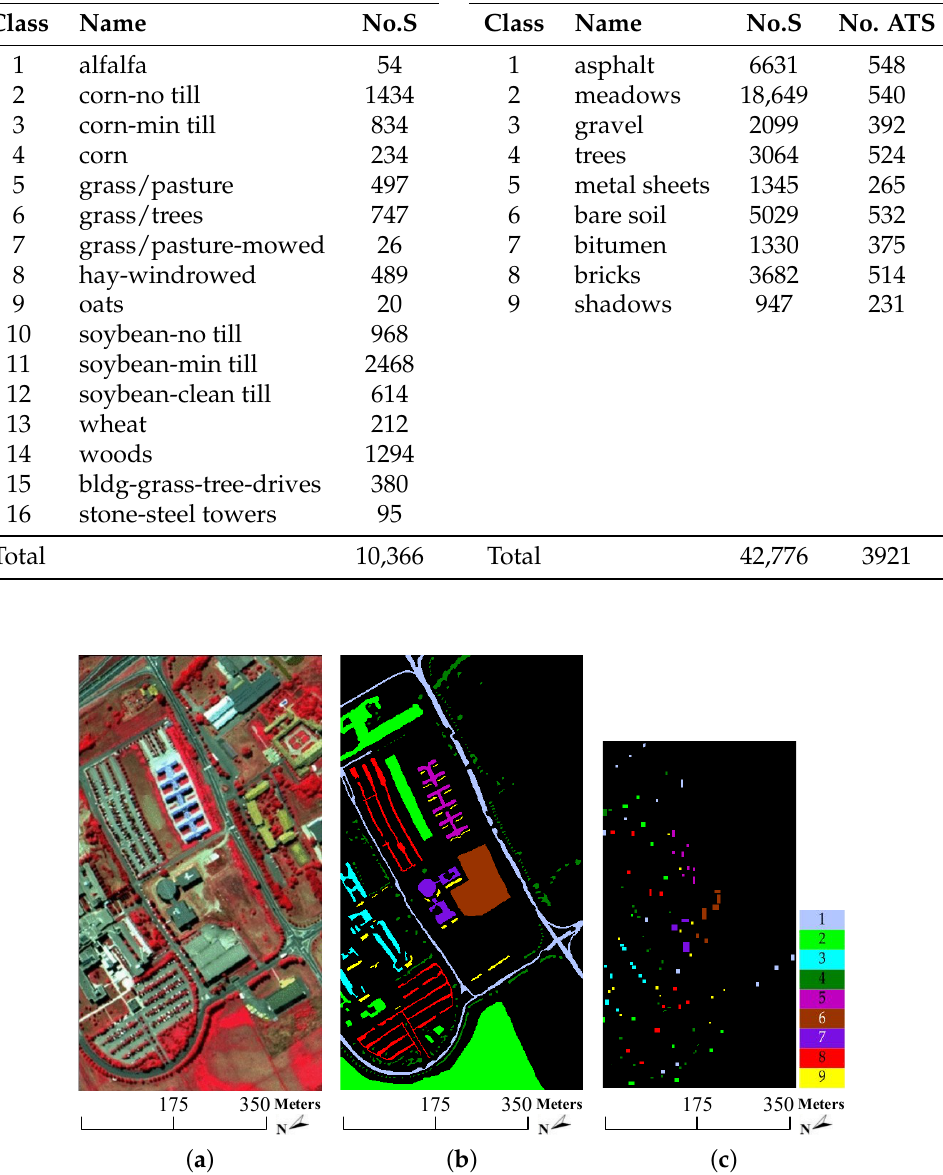
Figure 6. University of Pavia image: ( a ) Three-band false color composite; ( b ) Ground truth data with 9 classes; ( c ) Available training